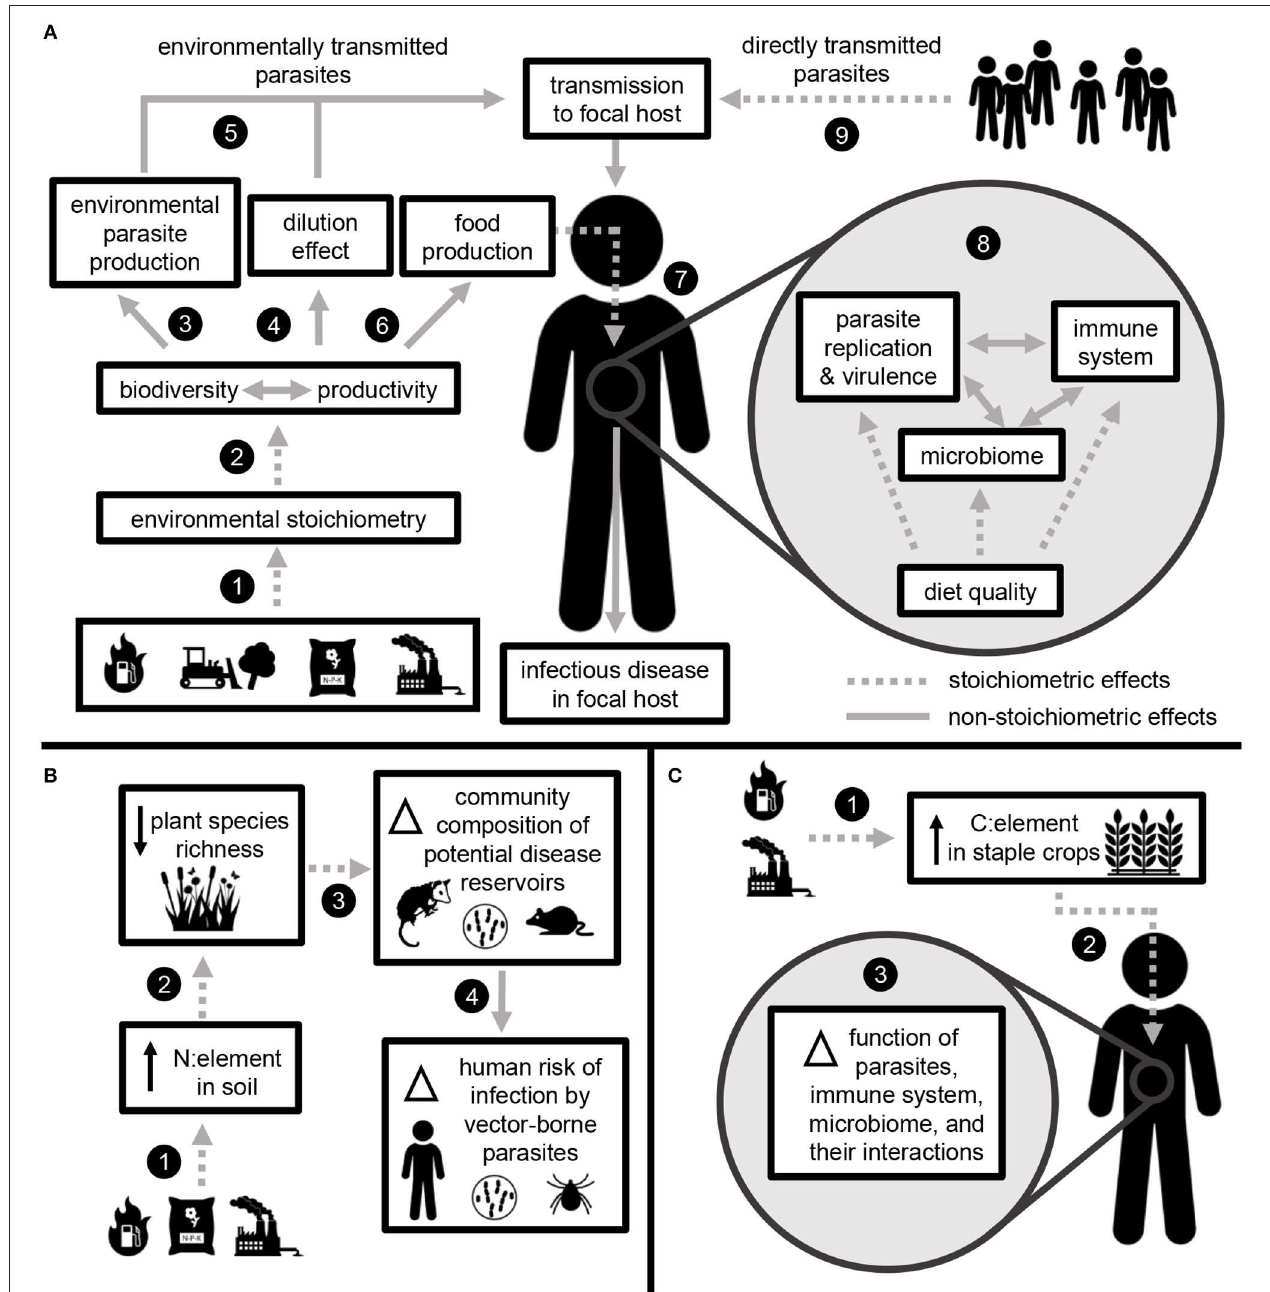
FIGURE 4 | Elemental ratios link global change with infectious disease through stoichiometric effects occurring in the environment and within the human body. (A) Fossil fuel combustion, land use change, fertilizer application, and industrial pollution change the relative availability of elements in the environment (1). Environmental stoichiometry impacts the key ecosystem processes of biodiversity and productivity (2). These processes impact the production of environmentally transmitted parasite species (3). Biodiversity may mediate parasite transmission to human hosts via the dilution effect (4). Together, these processes impact the rate at which human hosts are exposed to environmentally transmitted parasites (5). Biodiversity and ecosystem productivity also impact food production (6), and elemental ratios in human diet (7) lead to stoichiometric effects on infectious disease development within the body. Diet stoichiometry impacts the function of parasites, the non-pathogenic microbiome, and the immune system (8), which collectively determine the development of infectious disease within an individual host. The same within-host processes also apply to the development of disease caused by directly transmitted parasites (species that do not require environmental replication) (9). (B) Example: Human-driven changes to N availability increase N:element ratios in soil (1), which can contribute to declines in plant community diversity (2). Changes in plant diversity may alter the richness and composition of consumer communities, including potential reservoir hosts for infectious diseases of humans (3). The diversity of host communities may impact disease vector abundance and human risk of infection through a dilution effect (4). (C) Example: Anthropogenic increases in CO 2 lead to increased C:element in food crops (1), which corresponds to reduced nutritional quality (as dietary C:element) (2). Within a human host, changes to diet stoichiometry may impact the function of parasites, the microbiome, the immune system, and their interactions. Collectively, these functions determine the development of infectious disease (3).